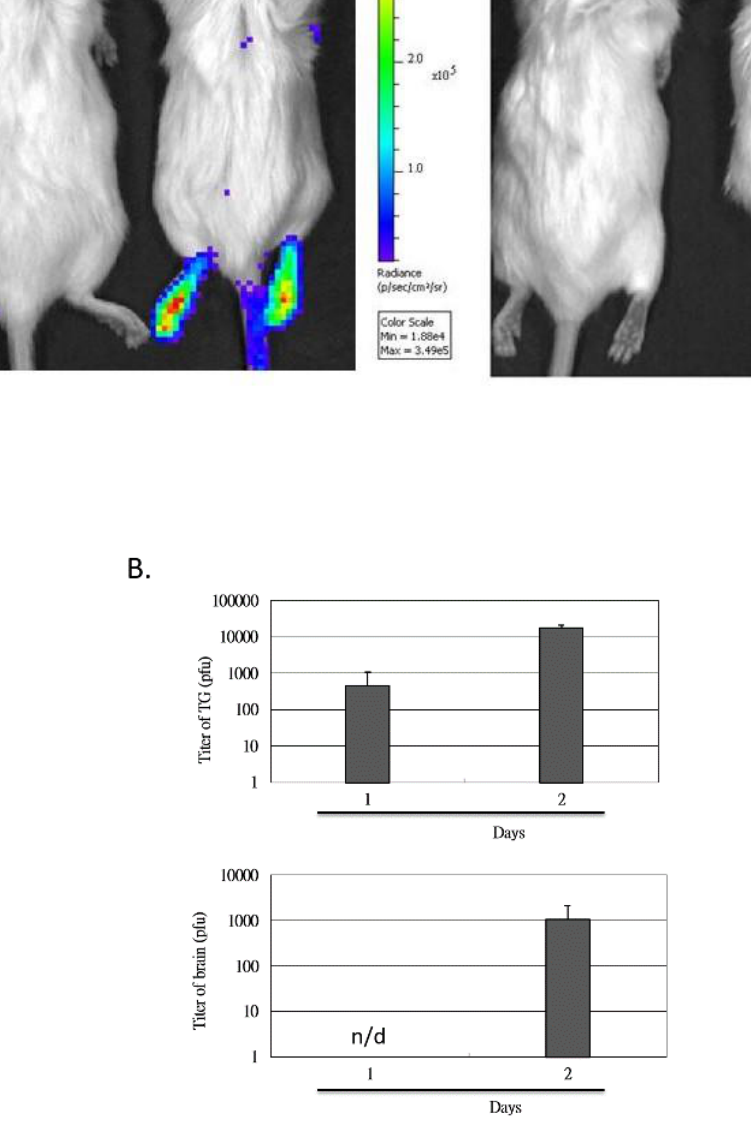
Figure 3 . Quantification of the imaging of 6-week-old FVB/NJNarl-Tg (NF- κ B-Luc)11Tsai mice after intranasal inoculation of PRV. Activities of NF- κ B pathway-triggered luciferase expression were detected in the brain of PRV-infected mice at 1 and 2 dpi ( A ). Replication in the mouse brain and